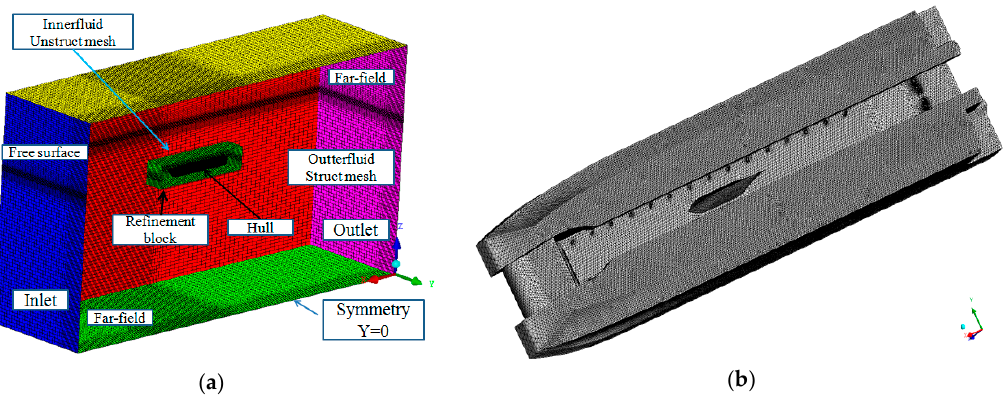
Figure 7. Calculating mesh. ( a ) Calculation domain setup and set boundary conditions; ( b ) Hull mesh.